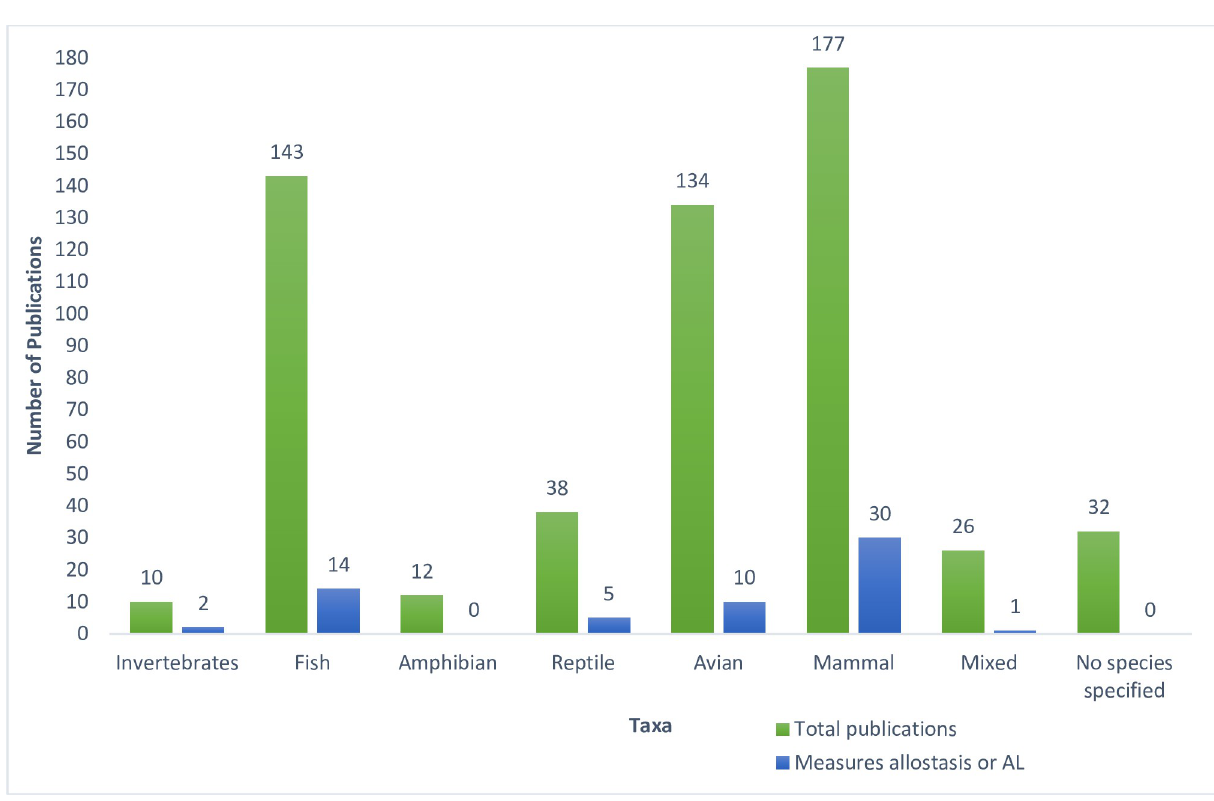
Fig 3. Publications that used allostasis terminology and directly assessed allostatic load in animals broken down by taxa. A total of 572 articles were identified in the non-human animal literature using terms related to allostasis and/or allostatic load across all taxa. Of these, 63 directly assessed and made conclusions about allostatic